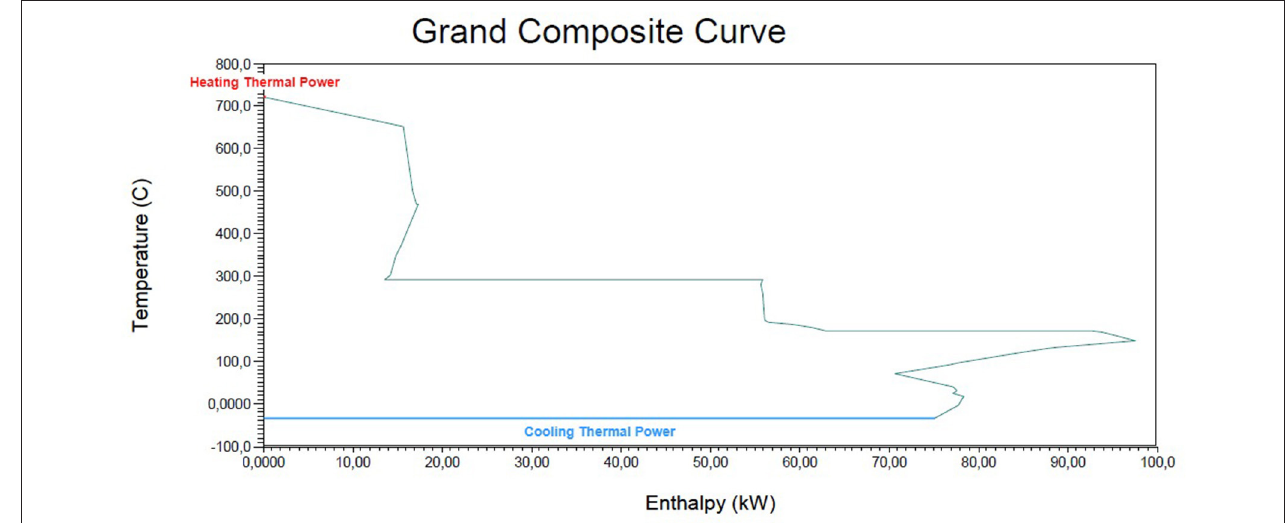
FIGURE 8 | Grand Composite Curve of the process stream for Case